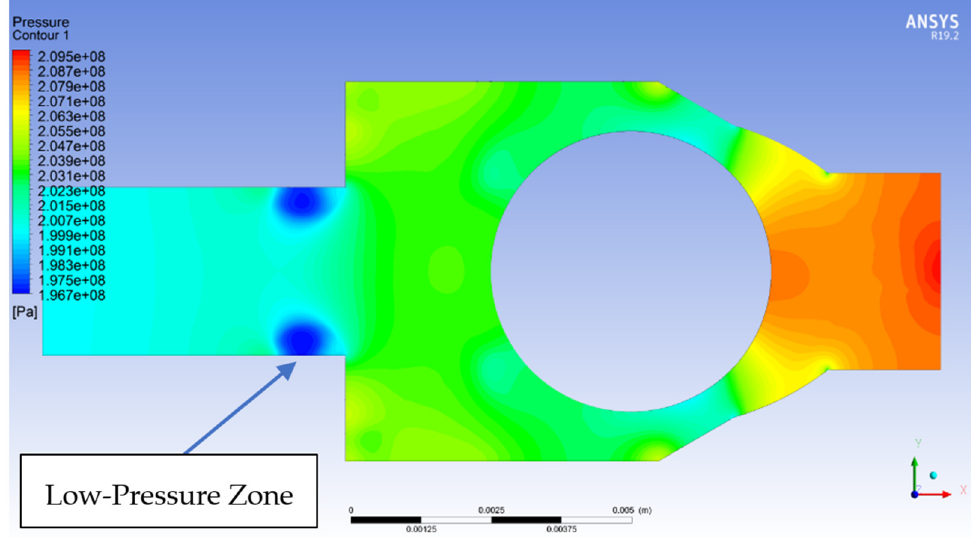
Figure 10. Pressure CFD: Spherical Seat Valve − x = 1.005 [mm], p dn = 2000 [bar] and p up = 2100 [bar].